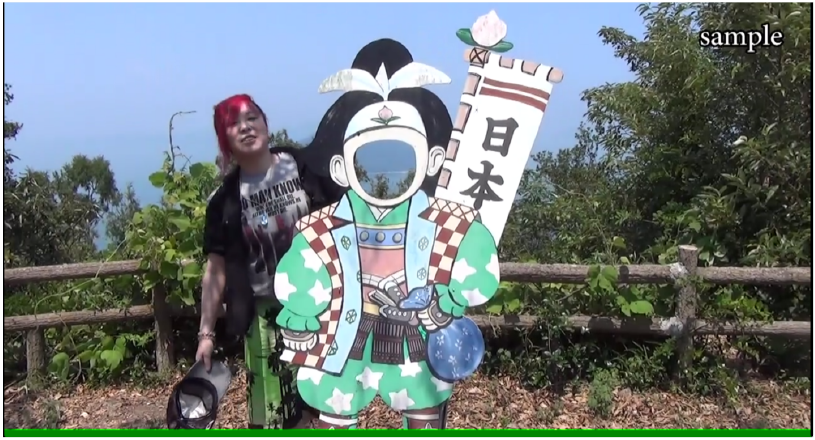
Fig. 10. Marking the boundaries between one’s personas? After Gamushara